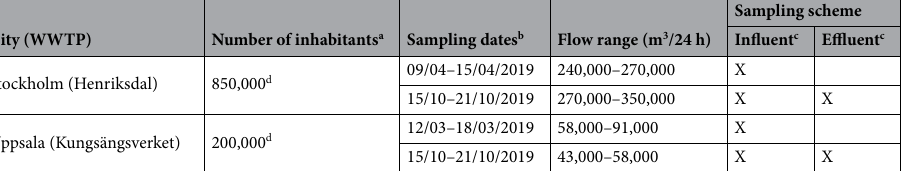
Table 1. Wastewater sampling in this study. a Data from WWTP staff incorporated with 2019 census data. b From Tuesday to Monday next week. X: collected samples. c Flow-proportional sampling. d Cover about 87% of the municipality